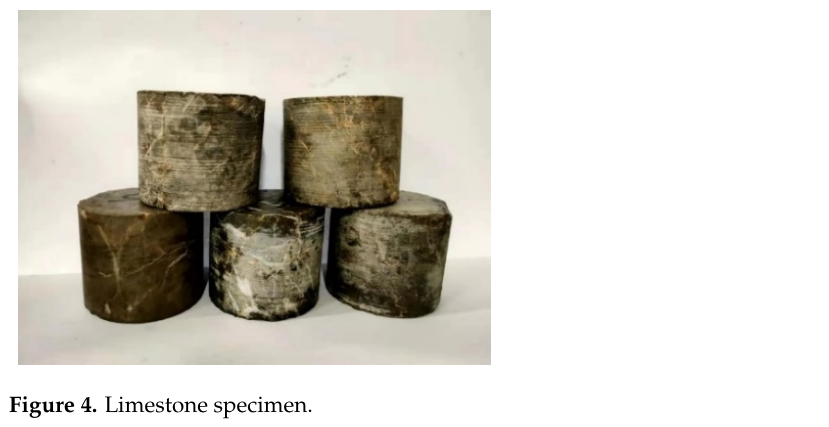
Figure 5. Heating temperature control curve. In order to explore the influence of confining pressure and temperature damage on the dynamic mechanical properties of limestone specimens, the specimens were subjected to different temperatures and different confining pressures at loading impact velocities of 5.3 m/s and 8.6 m/s. For comparison, the dynamic mechanical properties of the limestone specimens at room temperature were also tested at the corresponding impact rates without confining pressure. Three independent experiments were carried out under each working condition. 3. Experimental Results and Analysis 3.1. Experimental Results The SHPB test system with a confining pressure device was utilized to study the ef- fects of temperature (25 °C, 200 °C, 400 °C, 600 °C, and 800 °C), confining pressure (0.5 MPa, 1.5 MPa, and 2.5 MPa) and impact velocity (5.3 m/s and 8.6 m/s) on the dynamic mechanical properties of limestone. The experimental results are shown in Table 1. In Table 1, a confining pressure of 0 MPa indicates that the dynamic impact experiments were carried out in a uniaxial state, and a temperature of 25 °C indicates that the dynamic impact experiments were per- formed at room temperature.